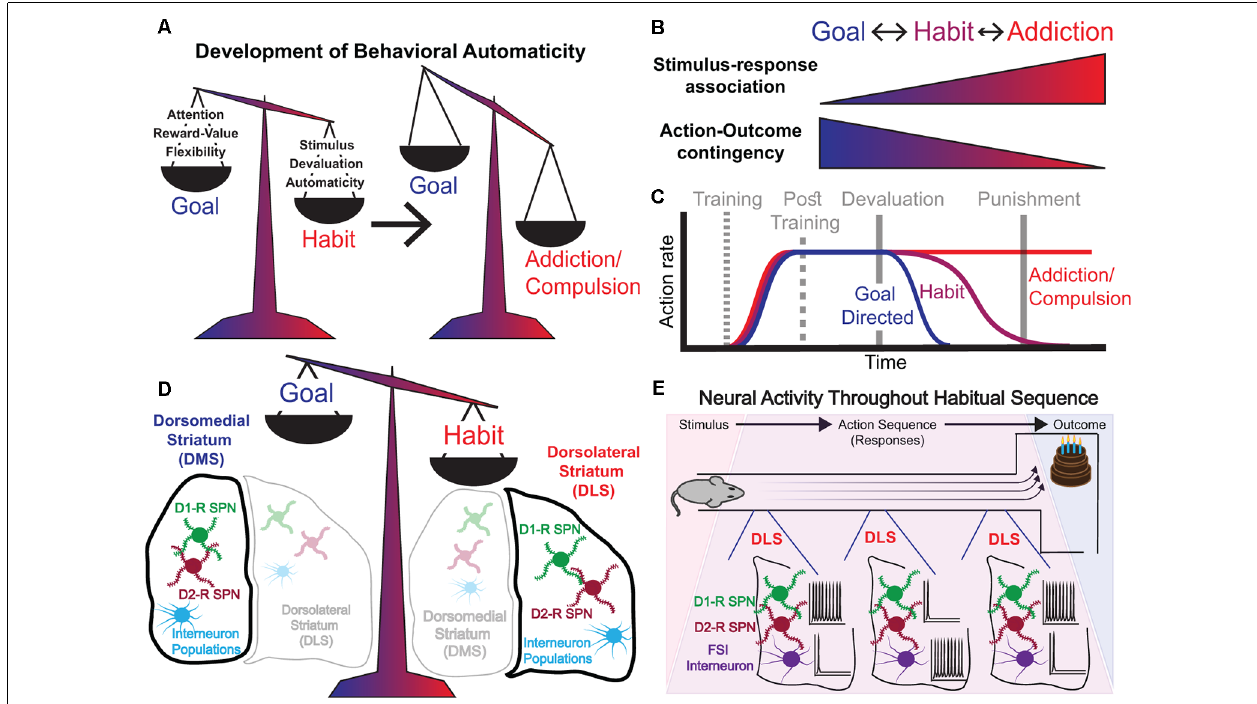
FIGURE 1 | Characteristics of the shift from goal-directed to habitual behavior. (A) Left: Goal-directed and habitual behaviors are competitive processes that act in balance. Goal-directed behavior is characterized by a high requirement for attention, is highly contingent on present reward value, and demonstrates flexibility of responding. Habitual behavior is stimulus-driven, less dependent on present reward value, and governed by behavioral automaticity. Right: Addiction/compulsion represents an extreme state of habit. (B) The transition from goal-directed behavior to habitual behavior and then into compulsion, or addiction is graded. Shift from goal-directed to habitual behavior and then to compulsion/addiction corresponds to strengthened stimulus-response association and reduced action-outcome contingency. These processes are bidirectional, i.e., a behavior can shift on the spectrum from goal-directed to habitual performance, and back again—though in the extremes of addiction whether it is possible to return fully to habit/goal-directed states is less clear. (C) During instrumental training, rates of responding for a reward increase. Post-training reward devaluation reduces response rates more quickly for goal-directed behaviors than it does for habitual behaviors, which take many more extinction trials to fully dissipate. The extremes of addiction are characterized by compulsive responding that is resistant even to punishment. (D) The balance between goal-directed and habitual behavioral states corresponds to relative levels of neural activity in the dorsomedial (DMS) vs. dorsolateral (DLS) striatum. (E) Task-bracketing activity pattern emerges in the DLS as animals are over-trained on a rewarded behavioral sequence (e.g., running a T-maze for a tasty reward). Spiny Projection Neurons (SPNs) exhibit high activity at the beginning of a learned motor sequence and again at the end as the animal approaches the reward. Fast-spiking interneurons (FSIs) exhibit high activity during the middle stages of a behavioral